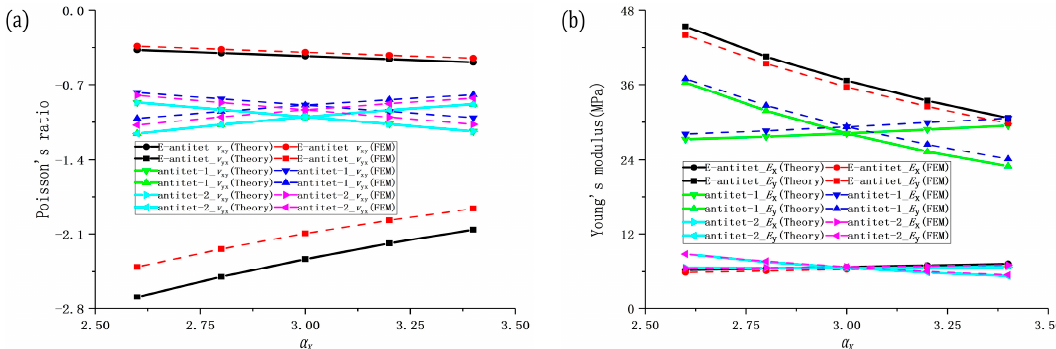
Figure 6. Trends of Poisson’s ratio and Young’s modulus of E-antitet at different α x : Comparison of the results of analytical and numercal solutions of E-antitet with antitet-1 and antitet-2. ( a ) Poisson’s ratio and (b) Young’s modulus